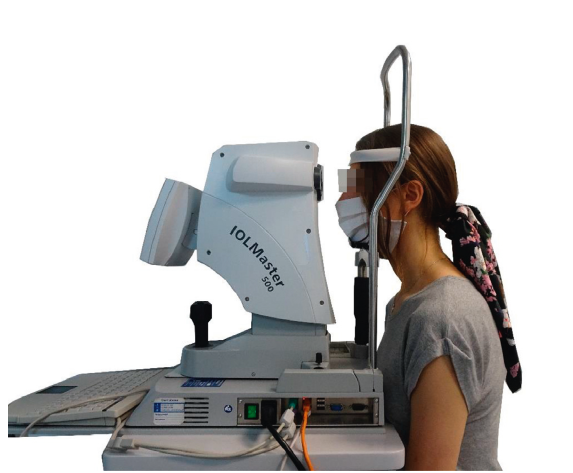
Figure 2: The axial length eyeball measurement during the